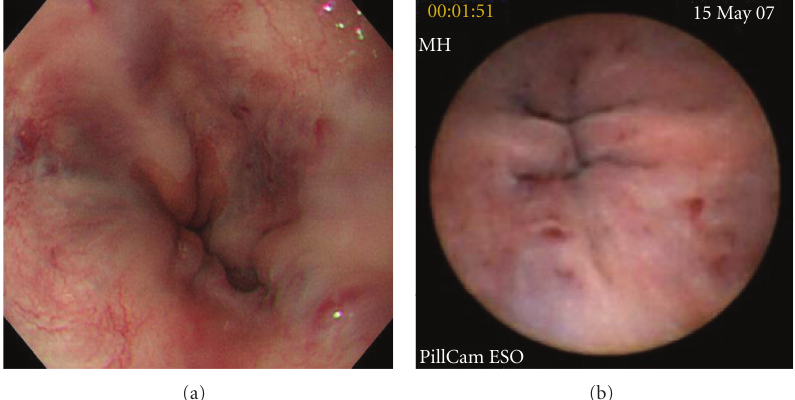
Figure 2: Images from a patient with good agreement between EGD (a) and ECE (b). This patient was classified as F1RC2 using both